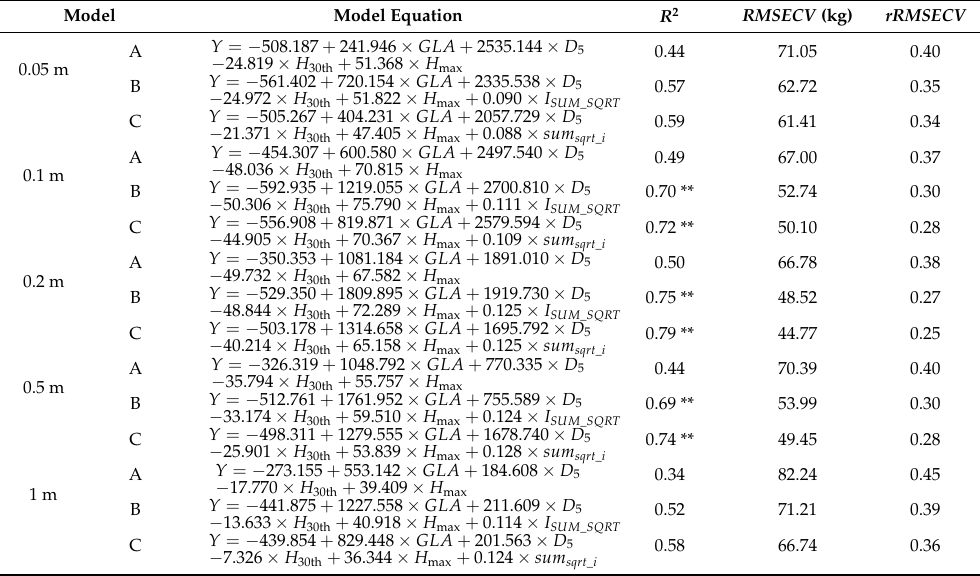
Table 5. Accuracy evaluation of models with different spatial resolution and